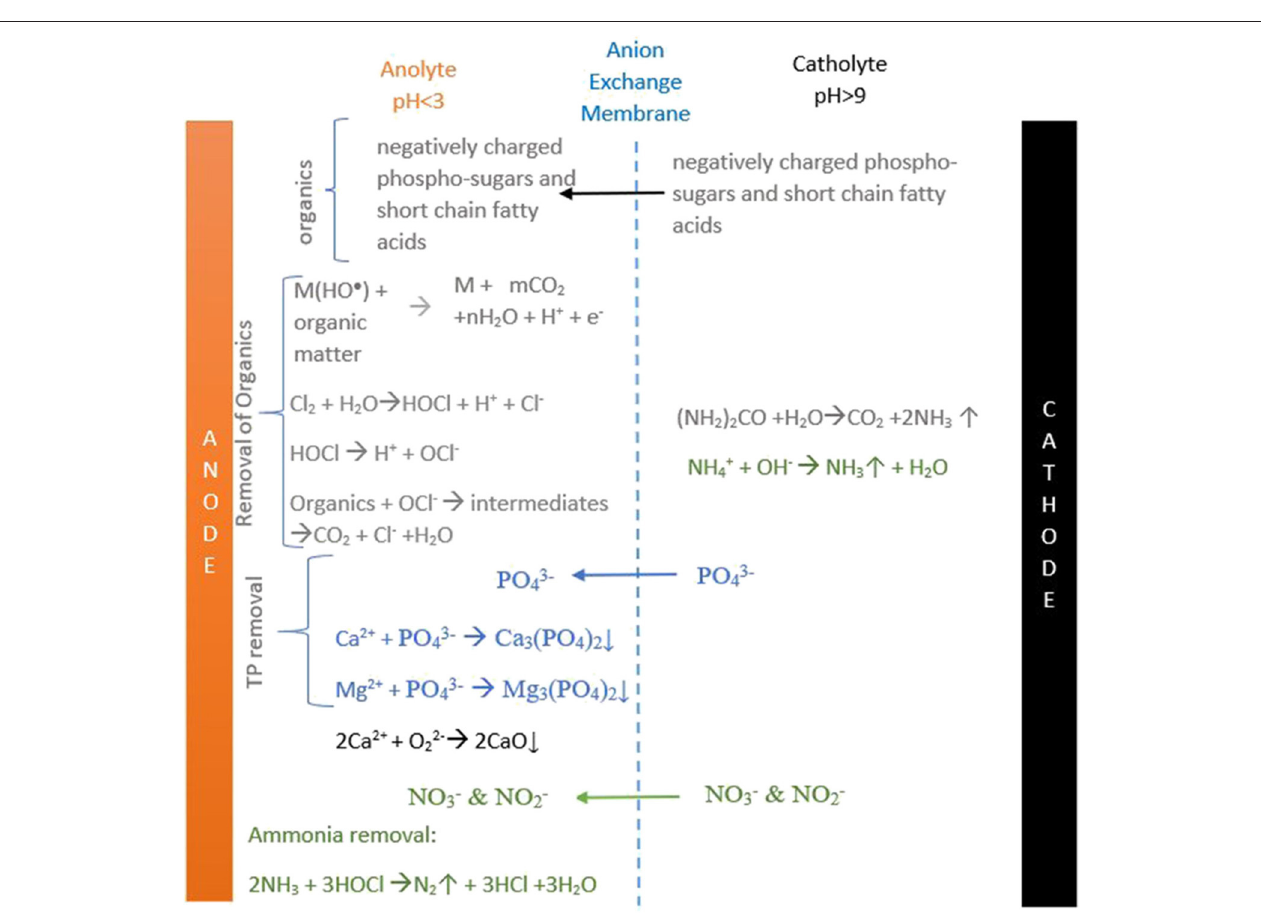
FIGURE 7 | Schematic diagram that summarizes all the major reactions occurring in the anode and cathode chambers of the ECR.